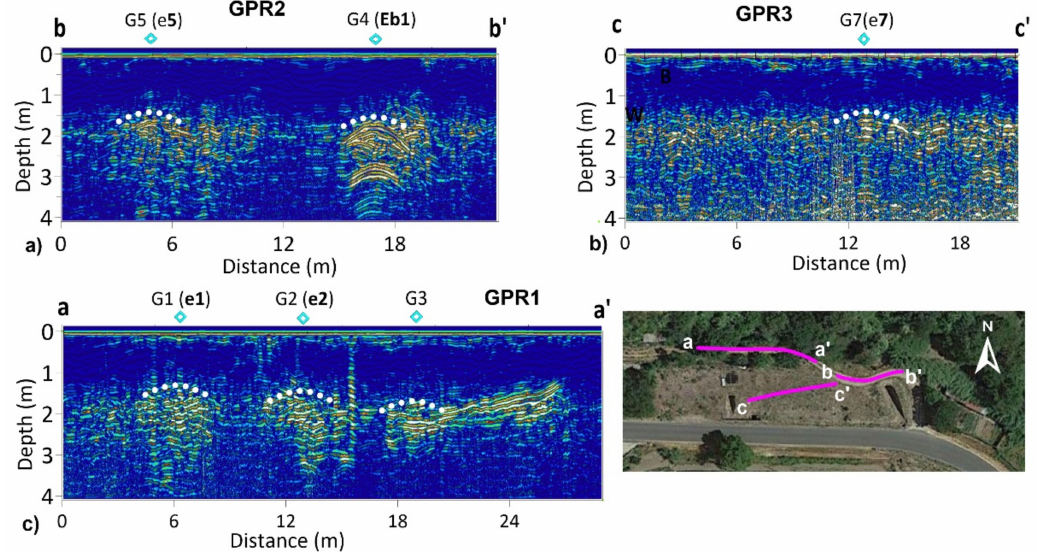
Figure 6. GPR radargrams. GPR radargrams obtained in the Vigna la Piazza Necropolis along ( a ) line b-b’ (GPR2 profile partially coincident with CCR2 line in Figure 3), ( b ) line c-c’ (GPR3 profile partially coincident with CCR2 line in Figure 3), and ( c ) line a-a’ (GPR1 profile partially coincident with CCR1 line in Figure 3). The dashed white lines mark the GPR anomalies associated with the presence of excavated (Eb1) and partially filled burials. Recovered GPR anomalies are labeled with capital letters from G1 to